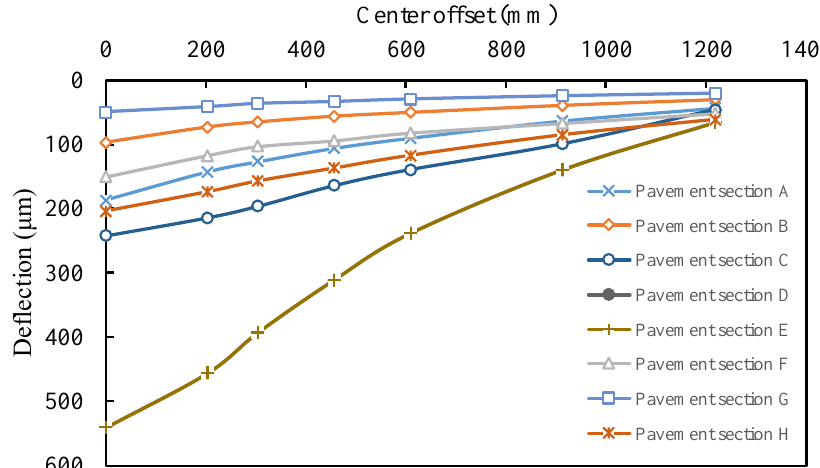
Figure 2. Deflection basin along the pavement cross-section.